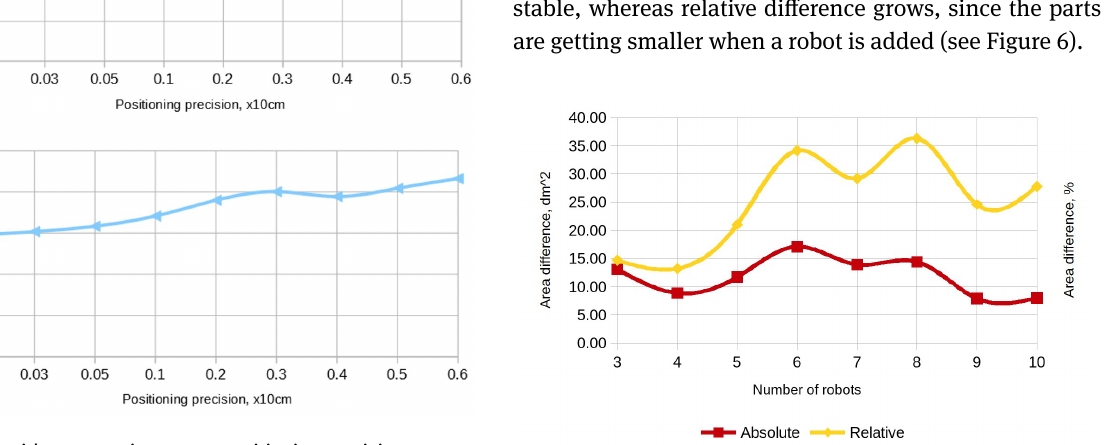
Figure 5: Algorithm properties versus positioning precision.